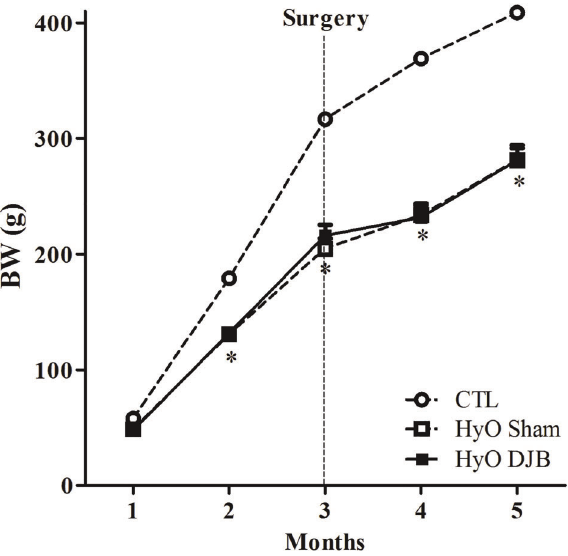
Figure 1. Body weight (BW) in control (CTL), hypothalamic obese (HyO) Sham and HyO with duodenal-jejunal bypass (DJB) rats, recorded during 5 months. Data are reported as means ± SEM (n=13 – 16). *P o 0.05, HyO Sham and HyO DJB groups compared to CTL (one-way ANOVA followed by the Tukey